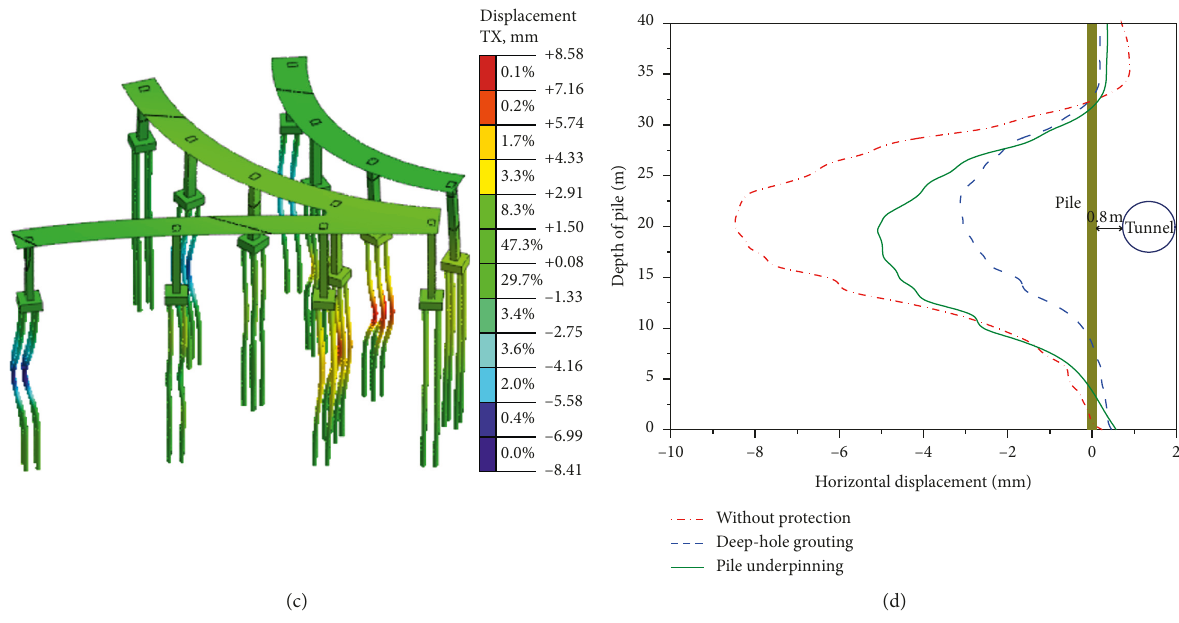
Figure 15: Horizontal displacement of piles: (a) deep-hole grouting; (b) pile foundation underpinning; (c) without protection; (d) horizontal displacement of the nearest